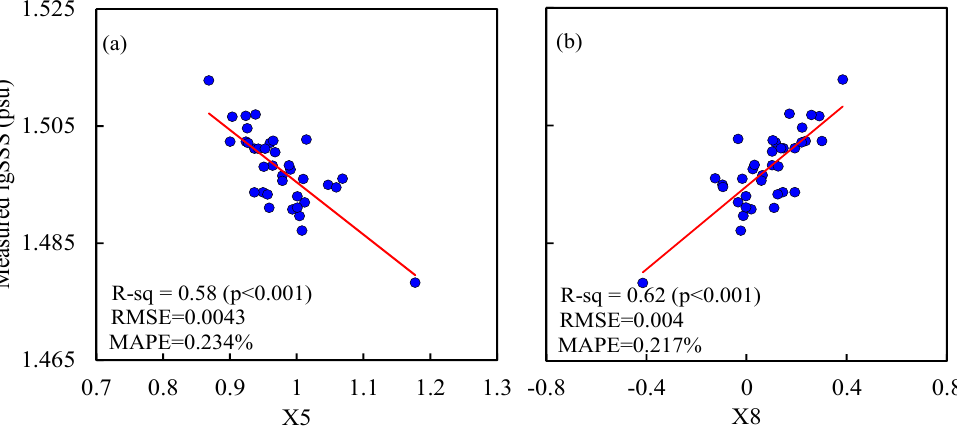
R-sq = 0.62 (p<0.001) RMSE=0.004